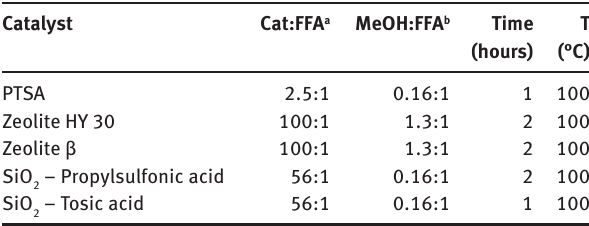
Table 3: Reaction conditions with the various catalysts.